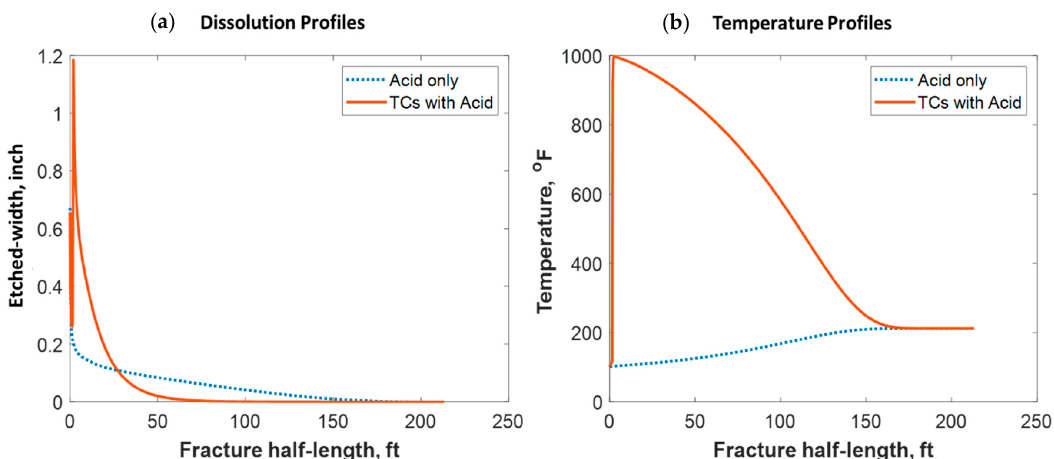
Figure 19. Comparison of the dissolution and temperature profiles when ( a ) acid with TCs was injected versus the ( b ) acid-only injection.